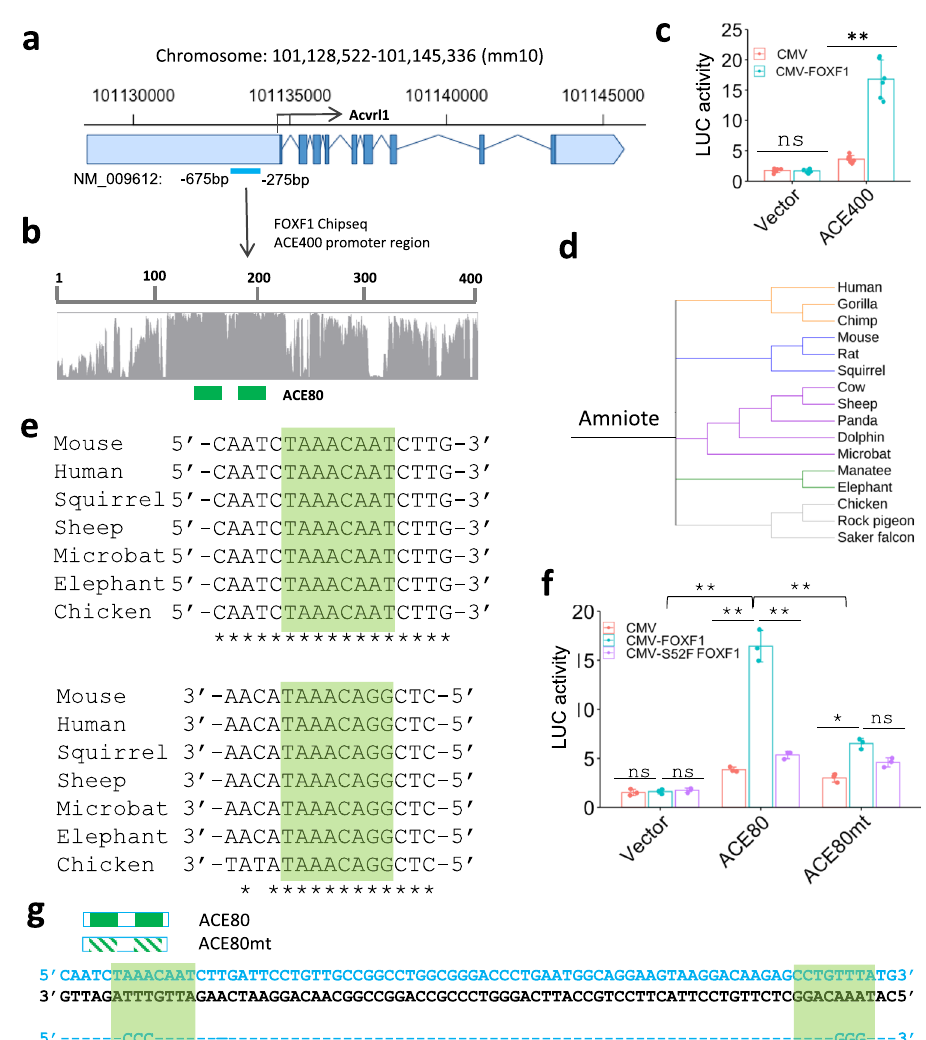
Fig. 5 FOXF1 activates Acvrl1 gene expression through the ACE80 promoter region. a , b Schematic diagram of the mouse Acvrl1 gene locus which contains the evolutionarily conserved − 675/ − 275 promoter region (ACE400). Light blue boxes show untranslated DNA regions. Dark blue boxes indicate exons in the Acvrl1 gene. Two FOXF1-binding sites are indicated by green boxes. c Dual luciferase assay shows that CMV-FOXF1 expression plasmid stimulates the ACE400 activity in co-transfection experiments in MFLM-91U cells ( n = 6). Data were shown as mean ± SD. T -test (two-tailed) were performed, pvalue for ACE is 0.00000158. p > 0.05 is not signi fi cant. CMV-empty expression plasmid (pCMV) and an empty LUC plasmid (vector) were used as controls. d Schematic shows the evolutionary conservation of ACE80 promoter region in amniote vertebrates. Amniotes were classi fi ed using UCSC genome browser into fi ve groups: primates (orange), Afrotheria mammals (green), Laurasiatheria mammals (purple), Euarchontoglires mammals (blue) and birds (grey). e Schematic shows sequences of two FOXF1-binding sites in ACE80 region in several species. f Dual luciferase assay shows that CMV-FOXF1 expression vector stimulates the ACE80 activity in co-transfection experiments in MFLM-91U cells ( n = 3). Data were shown as mean ± SD. The data were analyzed by one-way ANOVA followed by Tukey ’ s test (two-tailed). CMV-empty vector (CMV) and transcriptionally inactive S52F FOXF1 mutant plasmid ( CMV- S52F-FOXF1 ) are used as controls. LUC activity is decreased after co-transfection of CMV-FOXF1 plasmid with ACE80mt LUC reporter. ** p < 0.01, * p < 0.05, ns is not signi fi cant. g Location of FOXF1-binding sites in ACE80 region is indicated by green boxes. FOXF1-binding sites in ACE80mt construct were inactivated by disrupting the FOX core